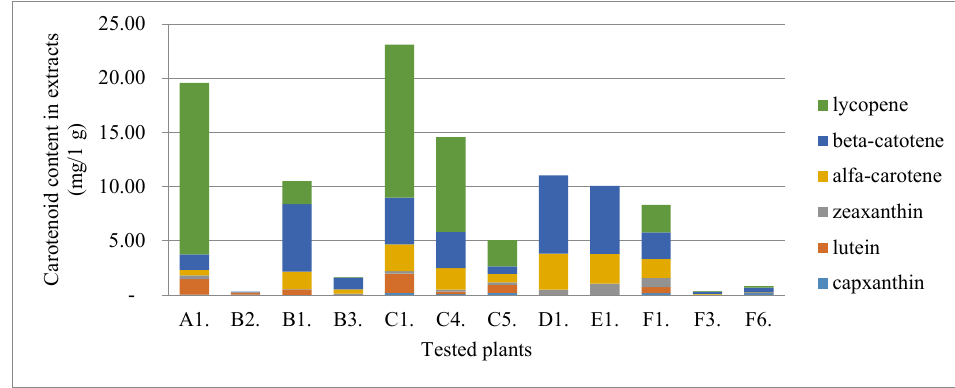
Figure 4. The content of carotenoids in the plants tested. Organic acids are the last group of essential compounds in plant raw materials. They determine the degree of fruit ripeness, taste, and the balance between alkalinity and acidity. Their activity as bioactive compounds is varied and not fully understood. The content of organic acids was about 1.5 mg/1 g of the extract to even 13 mg/1 g of the extract for sea buckthorn berries (Figure 5).